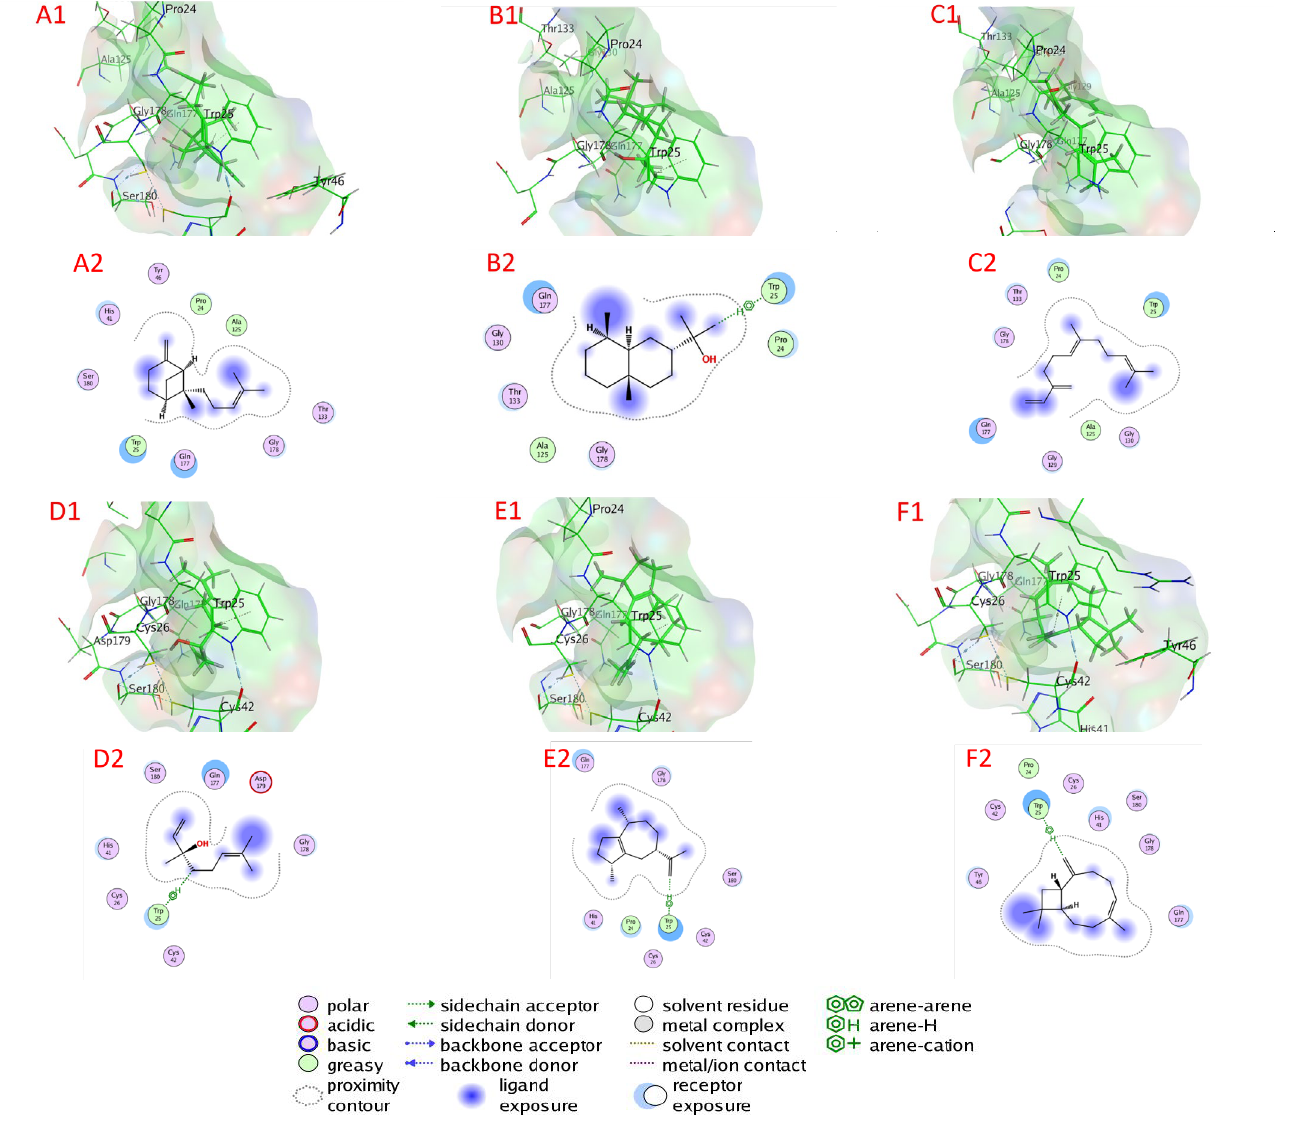
Figure 9. Docking view; ( A1 , A2 ) β -bergamotene, ( B1 , B2 ) α -eudesmol, ( C1 , C2 ) β -farnesene, ( D1 , D2 ) linalool, ( E1 , E2 ) α -guaiene, and (F1 , F2 ) β -caryophyllene in the binding sites of trypsin proteinase (PDB:1FN8). ( A1 , B1 , C1 , D1 , E1 , F1 ) 3D complex structures (stereoview) and ( A2 , B2 , C2 , D2 , E2 , F2 ) 2D interaction diagram structures.